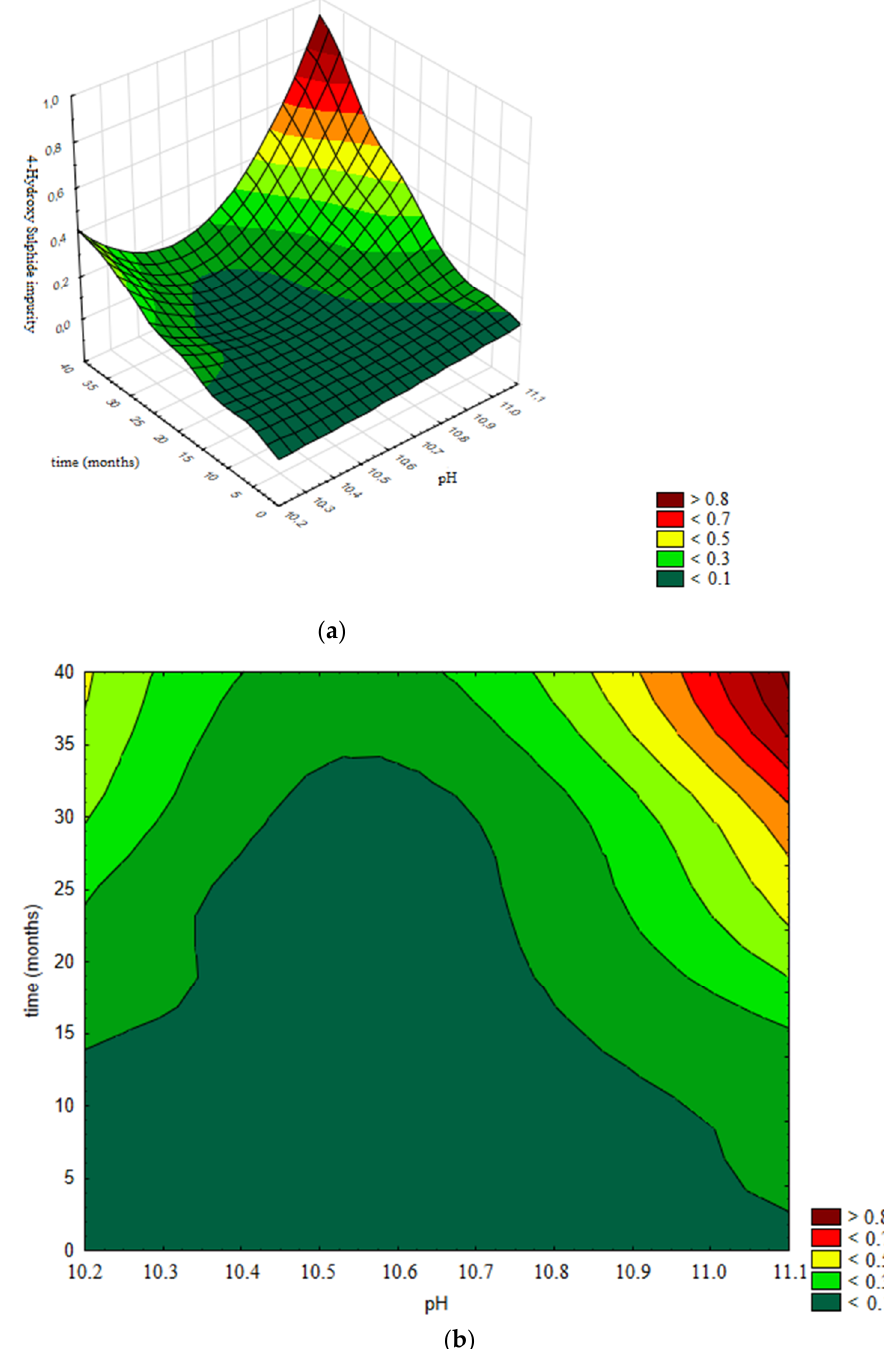
Figure 17. Influence of pH value and time on the assay of 4-Hydroxy Sulphide impurity: ( a ) Response surface; ( b ) Contour plot.